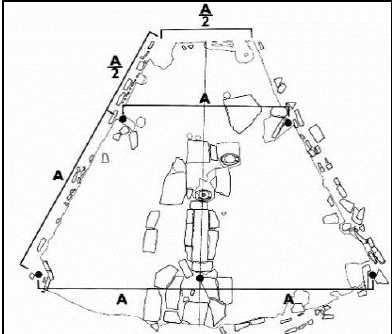
Figure 23. The foundation of the building, with clearly visible walls: two walls at an angle of 60 degrees are cut in advance and one semi-circular. It is simple in every sense [37]